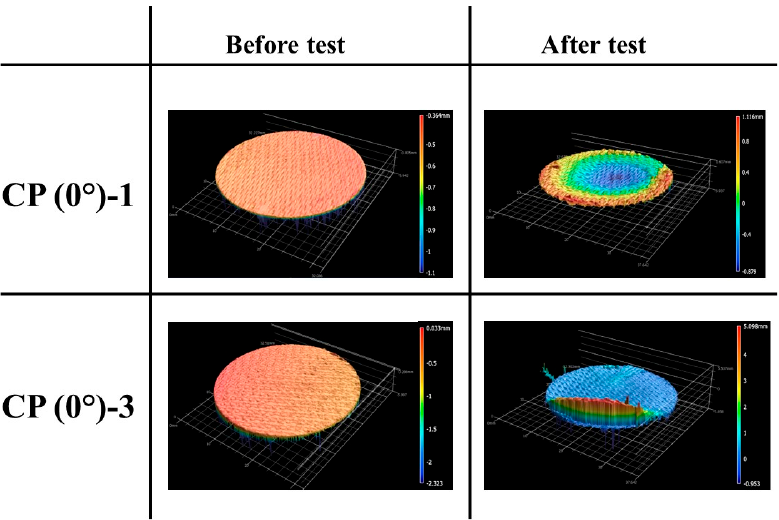
Figure 9. CP (0°)-1 (3.25 MW/m 2 , 60 s) and CP (0°)-3 (6 MW/m 2 , 30 s) before and after test images.